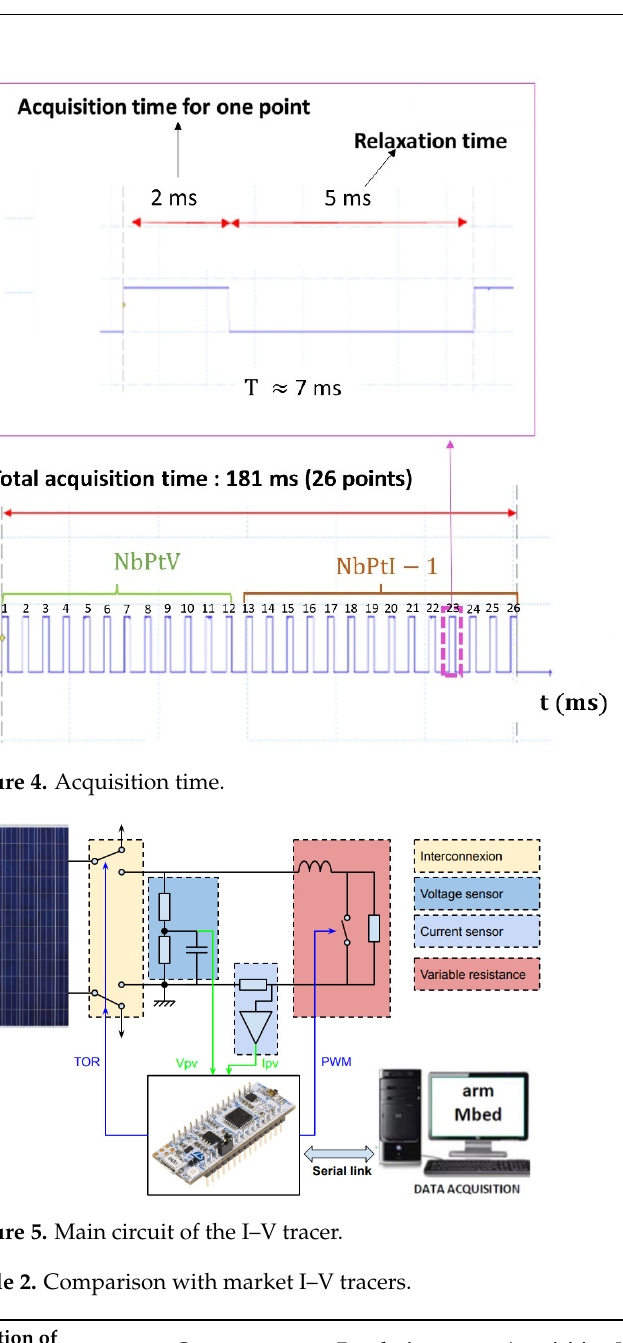
Figure 5. Main circuit of the I–V tracer.